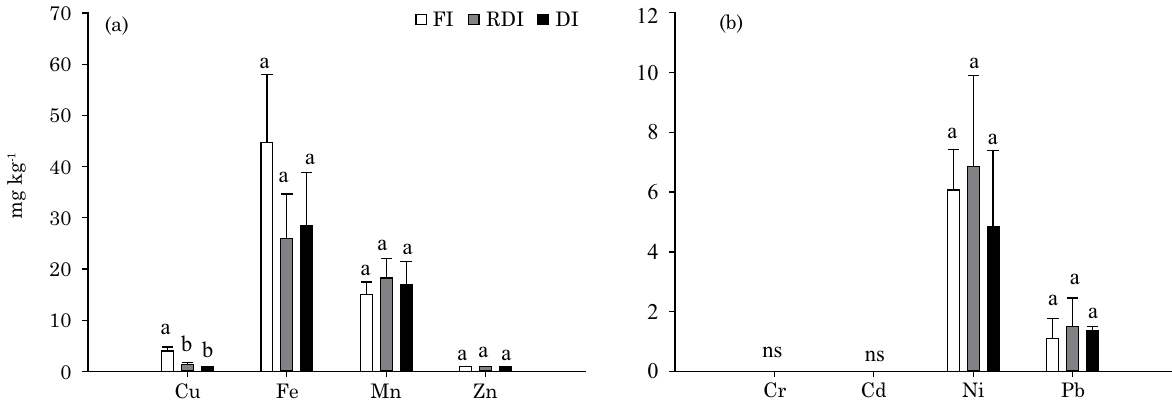
Figure 5. Micronutrient and heavy metal contents in grapevine under different irrigation strategies - full irrigation (FI), regulated deficit irrigation (RDI), and deficit irrigation (DI). Columns followed by the same letter do not differ among themselves by the Tukey test at 5 % of significance. The vertical deviation bars represent the standard deviation of the mean value (n =